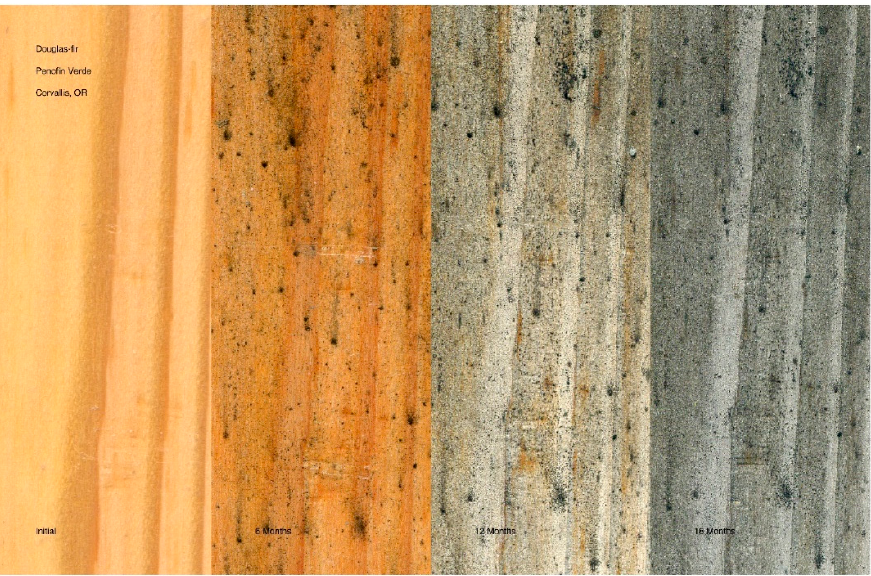
Figure 5. Example of the same Douglas-fir specimen treated with Penofin Verde and exposed outdoors on a test fence near Corvallis, OR for 0, 6, 12, and 18 months (left to right).